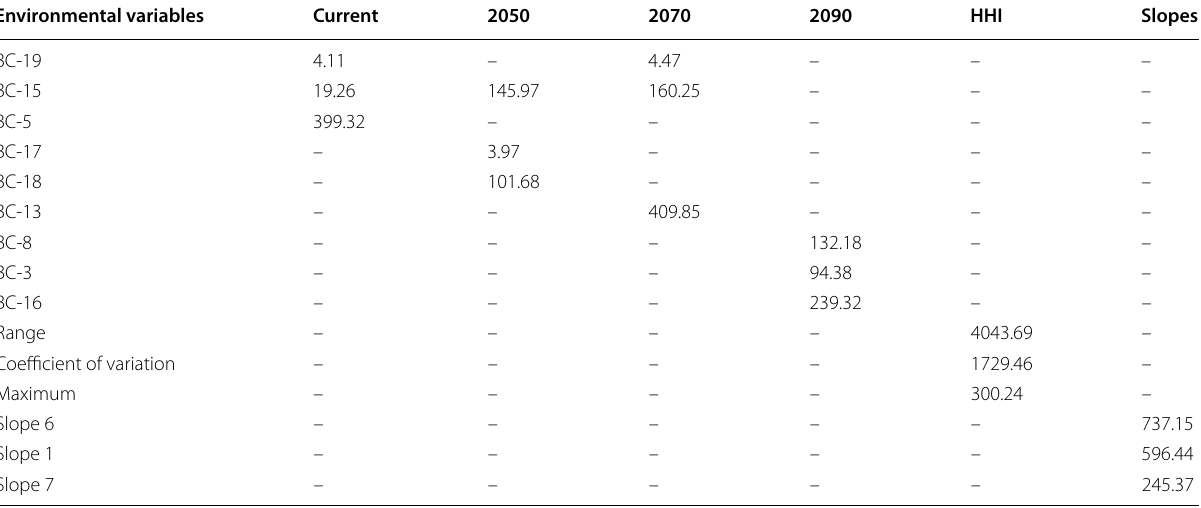
Values are corresponded to the distance of each predictors from the centre of hypervolume niche of C. wightii